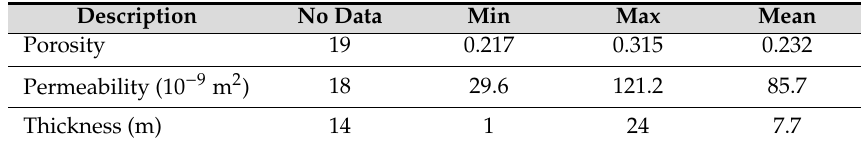
Table 1. Descriptive statistics of geological variables porosity, permeability and thickness data in the “K” reservoir.